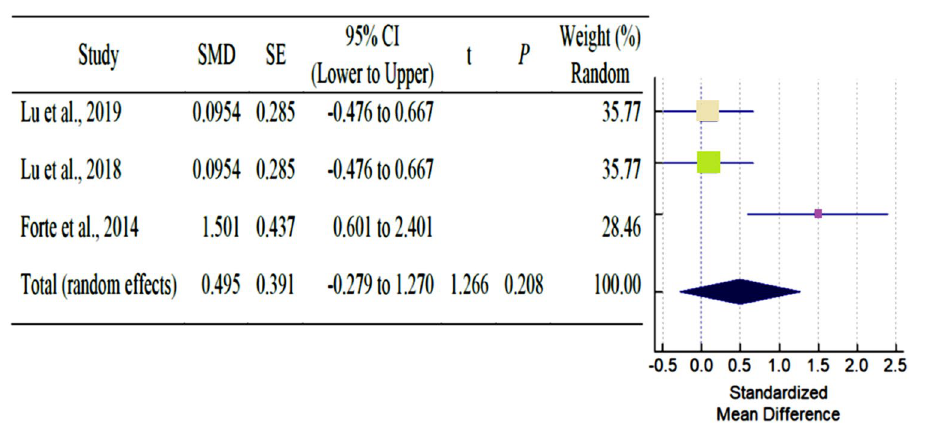
Figure 8. Forest plot for the outcome of SNA greater wing